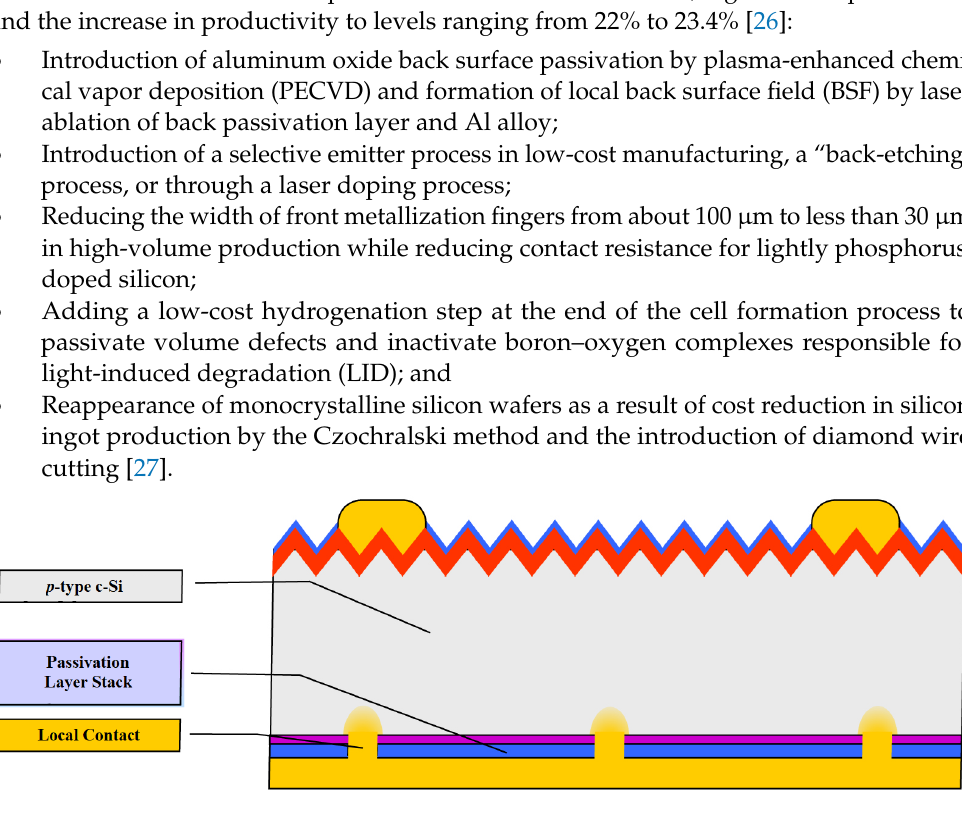
Figure 7. Silicon solar cell structure: PERC [1].